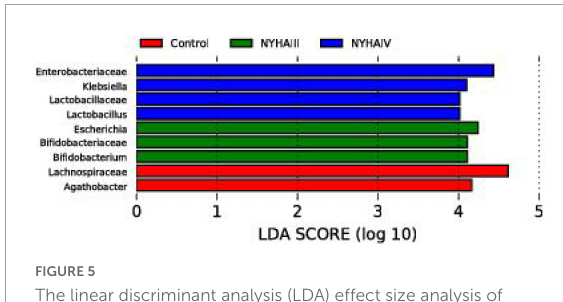
FIGURE5 The linear discriminant analysis (LDA) effect size analysis of Control, New York Heart Association (NYHA) class III, and NYHA class IV of bacteria with an LDA score > 4.